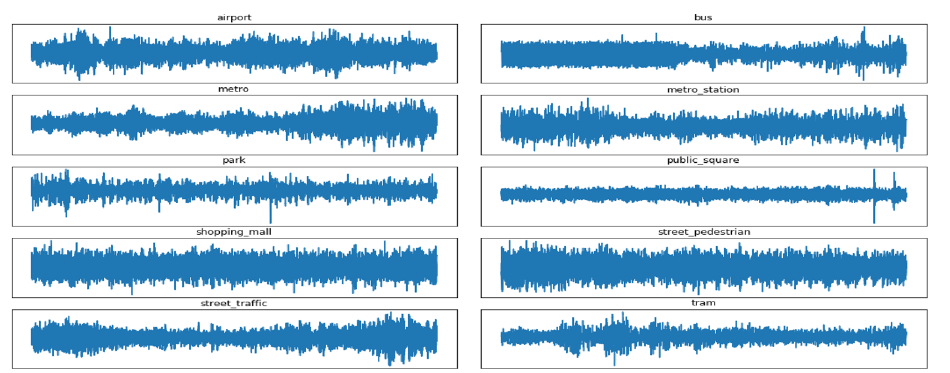
Figure 10. Signal waveform of each category in the DCASE2019